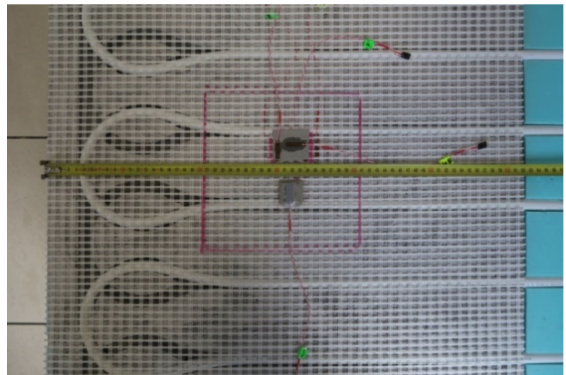
Figure 3. Attaching the strain gauges to C2S1 type adhesive, without lamellas.